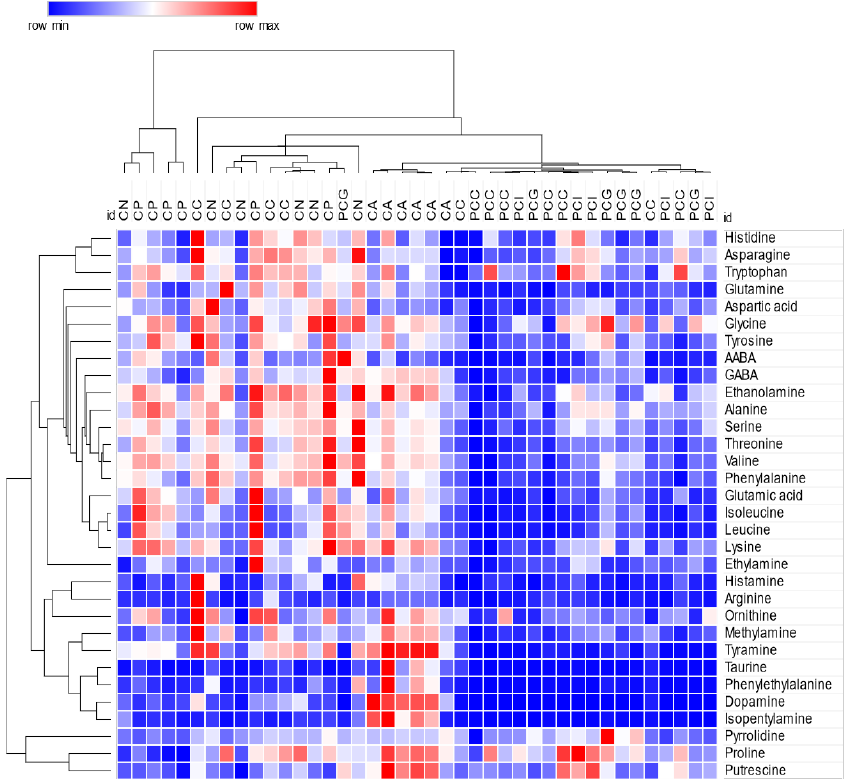
Figure 4 . Hierarchical clustering based on Pearson distances and heat-map visualization (42 samples × 32 compounds).